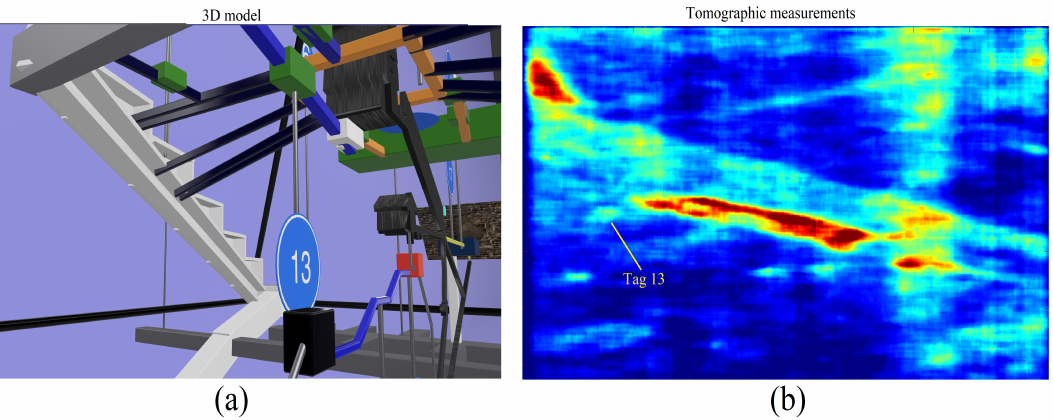
Figure 50. Tags association from tomography to 3D model. ( a ): Three-dimensional (3D) model of Khnum-Khufu. ( b ): Tomographic reconstruction (magnitude).